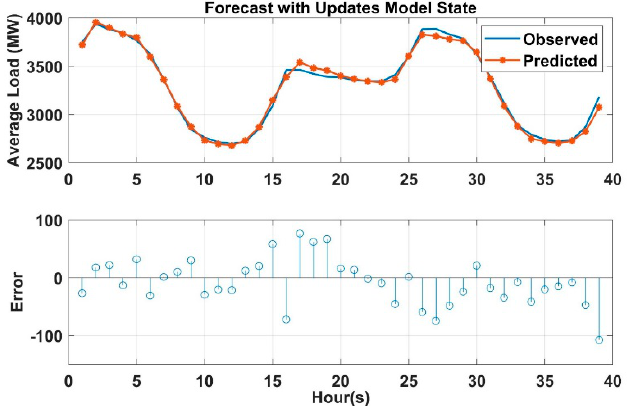
Figure 14. Comparison of per-hour forecast future time series using updated DNN model with test data (observed value).